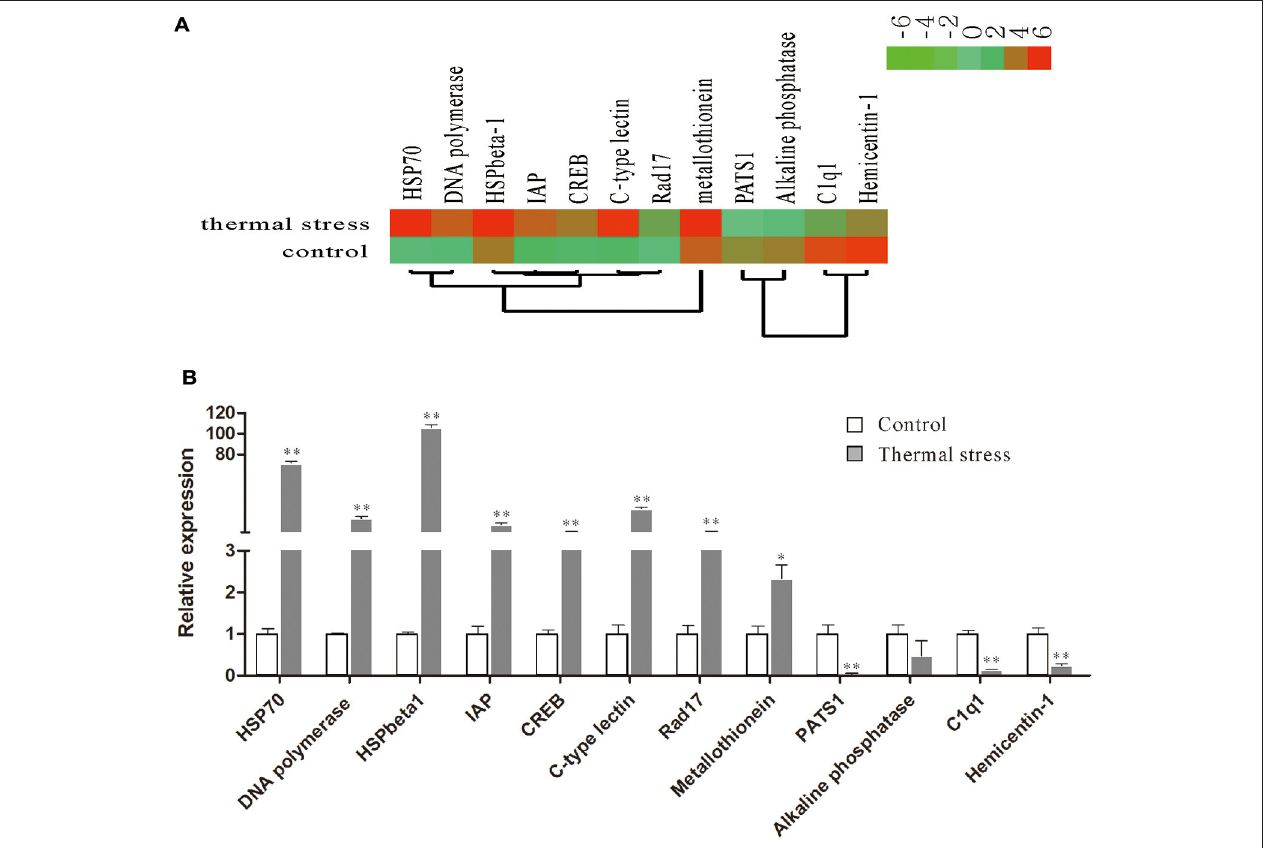
FIGURE 5 | Relative expression levels of selected DEGs in the thermal stress and the control group. (A) Hierarchical clustering of DEGs in the thermal stress and the control group. Red indicates up-regulation and green indicates down-regulation; (B) relative expression of DEGs verified by qRT-PCR. Each qRT-PCR reaction was run in five replicates with EF1 α as an internal control. Significant differences are indicated: * p < 0.05 and ** p < 0.01.